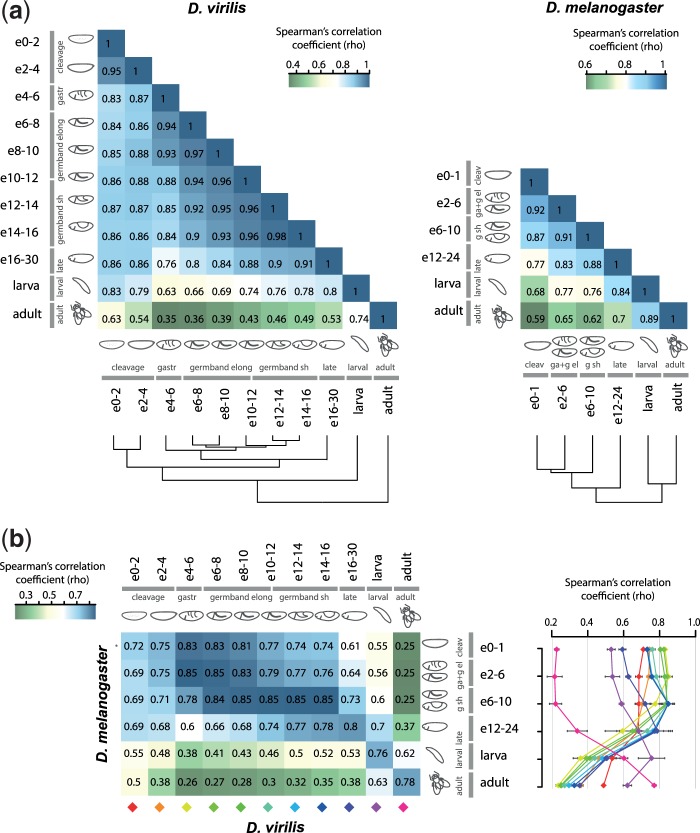
Similarity of global microRNA expression profiles between different developmental stages within (a) and between (b) the two species D. melanogaster and D. virilis. (a) Heatmaps representing Spearman’s correlation values for all-versus-all comparisons between different microRNA expression libraries in each of the two species: 2-h intervals within the first 16 h of D. virilis development (e0–2, e2–4, etc.), late D. virilis embryos (e16–30), larvae and adults; D. melanogaster 0–1, 2–6, and 6–10 h (e0–1, e2–6, e6–10), late embryos (e12–24), larvae and adults. Schematic drawings of each stage are based on morphology as determined in figure 1. Dendrograms were obtained by hierarchical clustering. (b) Left: Heatmap representing Spearman’s correlation values for all-versus-all microRNA expression libraries between the two species. Right: Spearman’s correlation values (x-axis) of cross-comparisons are plotted as colored lines corresponding to each stage of D. virilis (diamonds, colored as on the left panel) against each stage of D. melanogaster (y-axis); points represent average correlation values, and error bars represent the standard deviations of the coefficients for each D. melanogaster replicate.